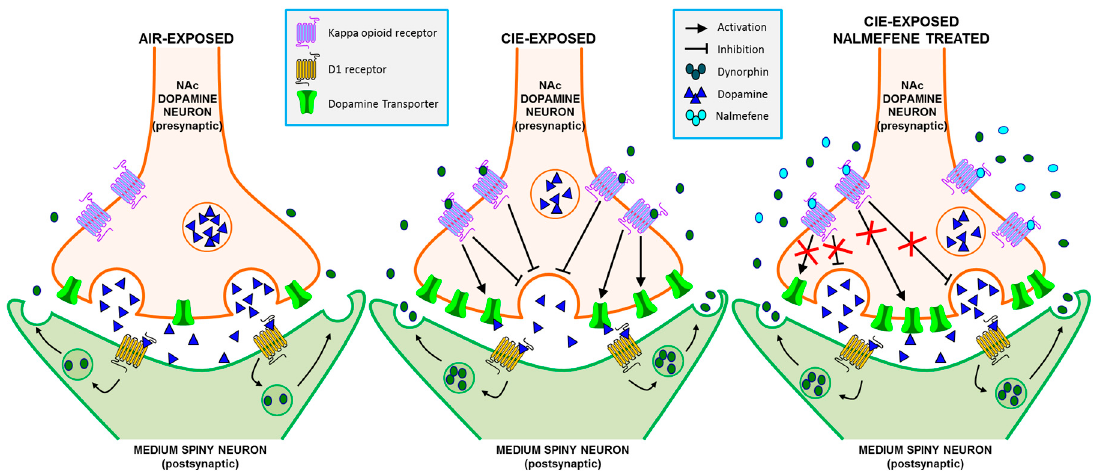
Figure 4. Schematic diagram of chronic intermittent ethanol (CIE)-induced changes in kappa opioid receptors (KOR), dopamine transporters (DAT), dopamine release, and dynorphin and nalmefene effects on KOR function based on the current hypotheses. In comparison to air-exposed mice ( Left ), CIE-exposed mice ( Middle ) have lower dopamine release and greater uptake rates. This is potentially caused by increased KOR responses, as KORs inhibit dopamine release and increase DAT function when activated. The increased responses could be caused by increased levels of endogenous dynorphin released from the postsynaptic medium spiny neurons, an increase in receptor expression on the membranes of the presynaptic dopamine neurons, or both. ( Right ) shows a synapse from CIE-exposed animals in the presence of nalmefene. Nalmefene slows the KOR agonist-induced augmentation of uptake rates and inhibits the reduction in dopamine release in CIE-exposed animals, thus normalizing the dopamine release and uptake.